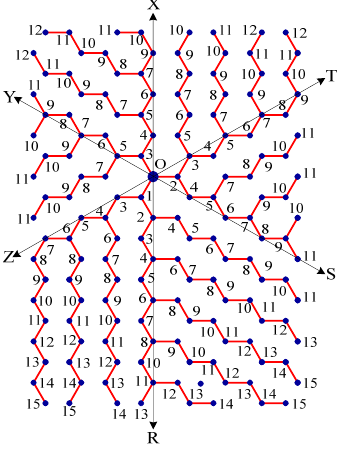
Figure 9. A node of label 5 means that the node receives the message from its neighbor at 5 th time